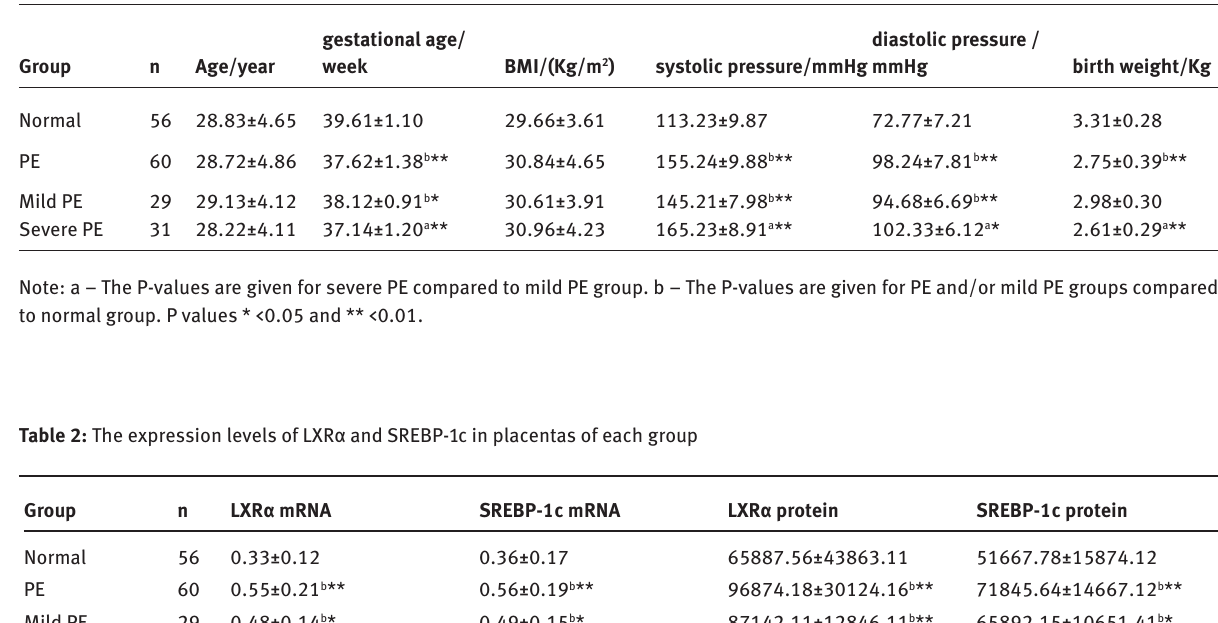
Table 1: Clinical characteristics of the control and PE patient groups